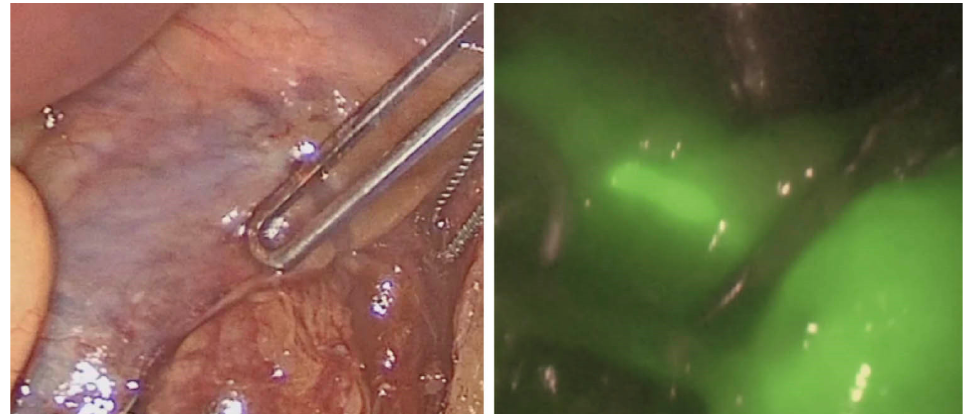
Figure 4. Sentinel lymph node identification using white light ( left ) and indocyanine green imaging ( right ). Courtesy of the International Society for Fluorescence Guided Surgery (ISFGS).